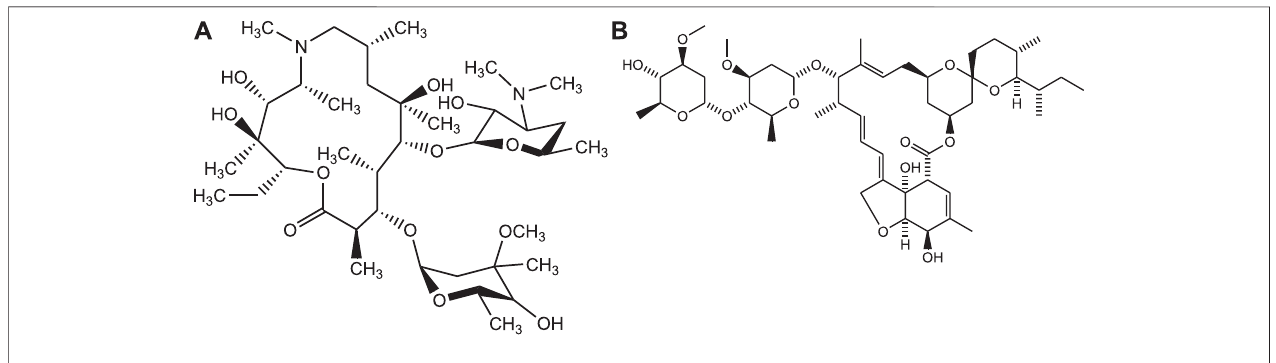
FIGURE 7 | Structures of azithromycin (A) and Ivermectin (B) .